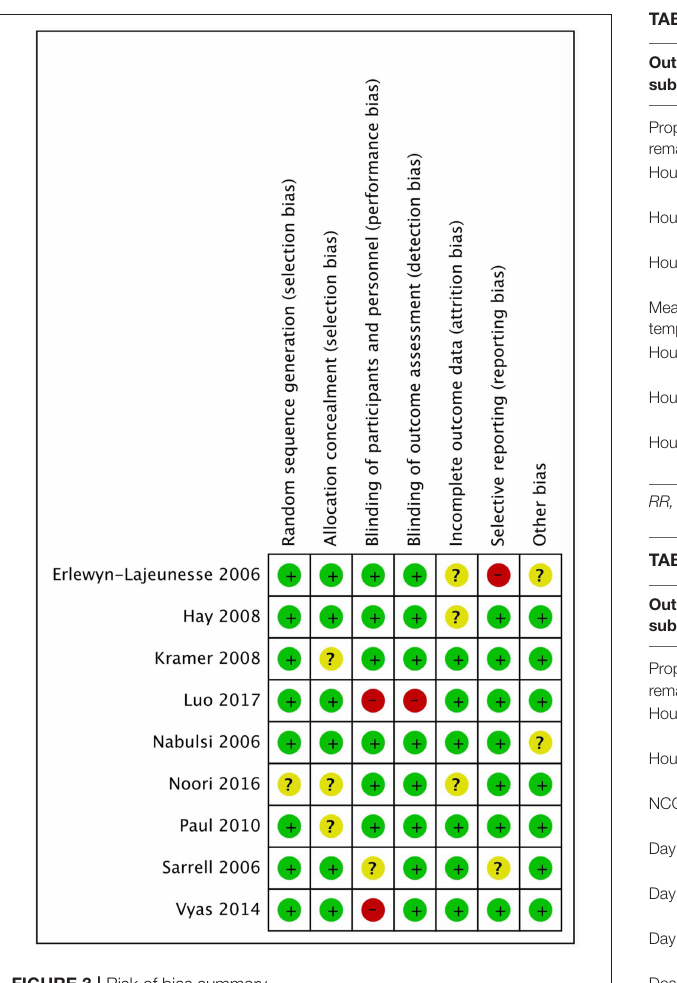
FIGURE 3 | Risk of bias summary.